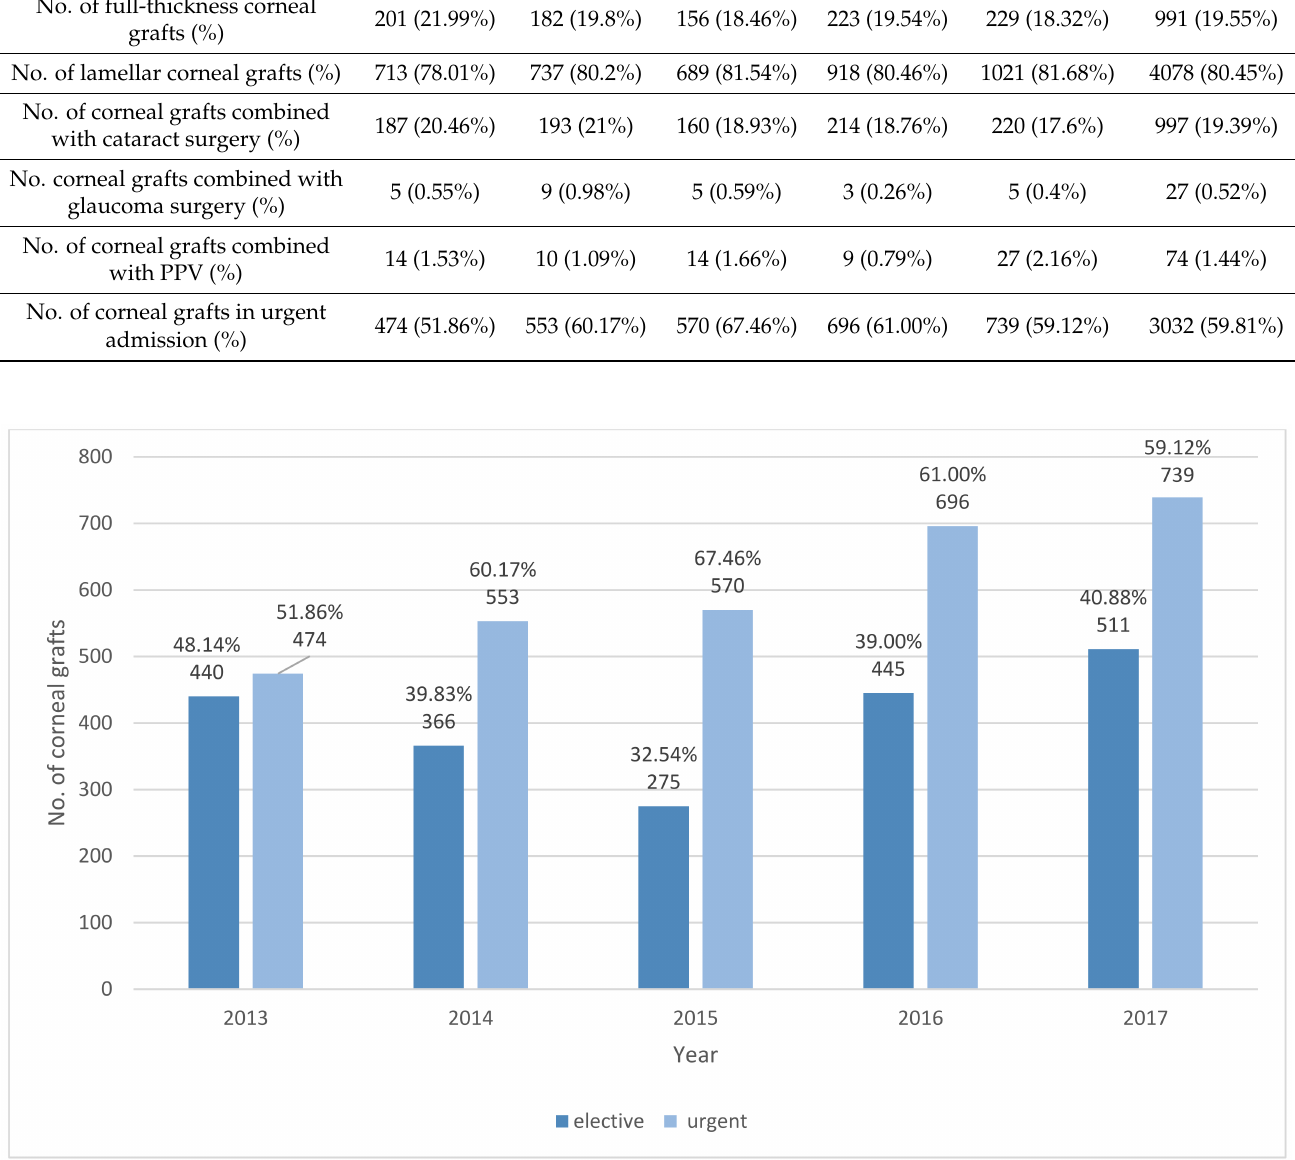
Figure 4. Number of elective and urgent corneal grafts in Poland during